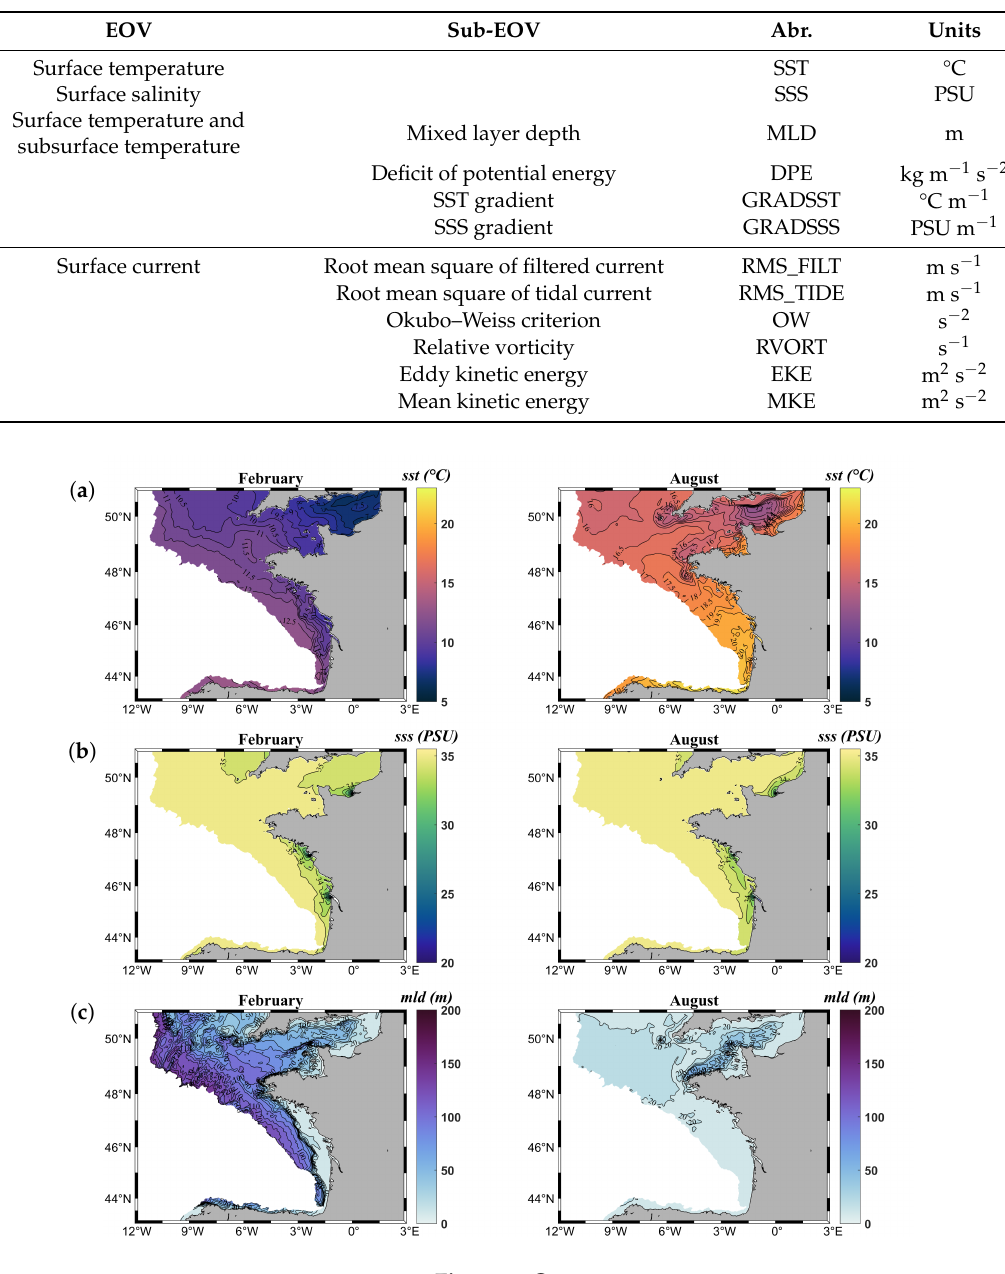
Table 1. Essential ocean variables and sub-variables used and units.